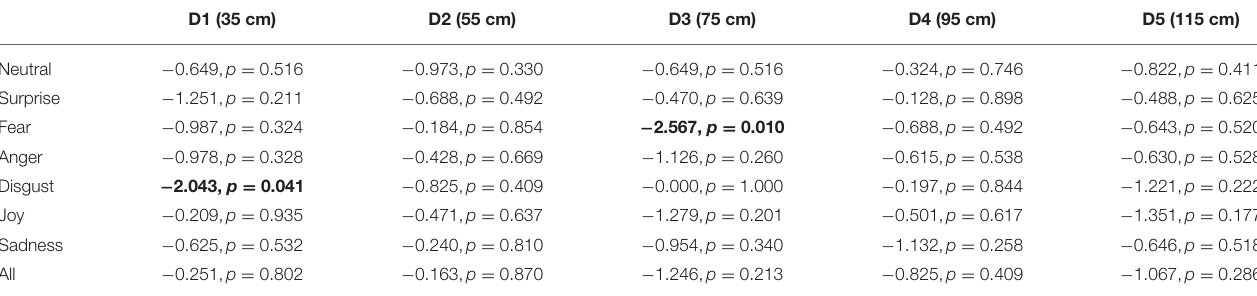
TABLE 6 | Results of the application of the Wilcoxon Signed Ranks Test ( Z ) to find differences in emotion identification between camera angles (front, side) per each